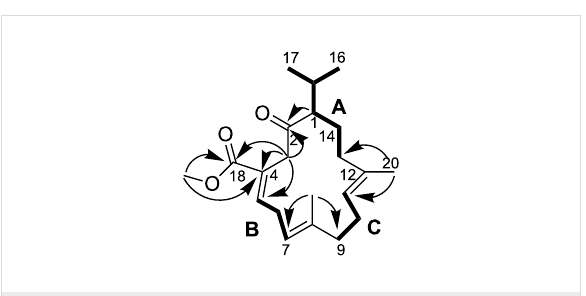
Figure 6: Structure of cembranoid 5 . 1 H, 1 H spin systems ( A , B and C ) are indicated in bold, arrows show key HMBC correlations.